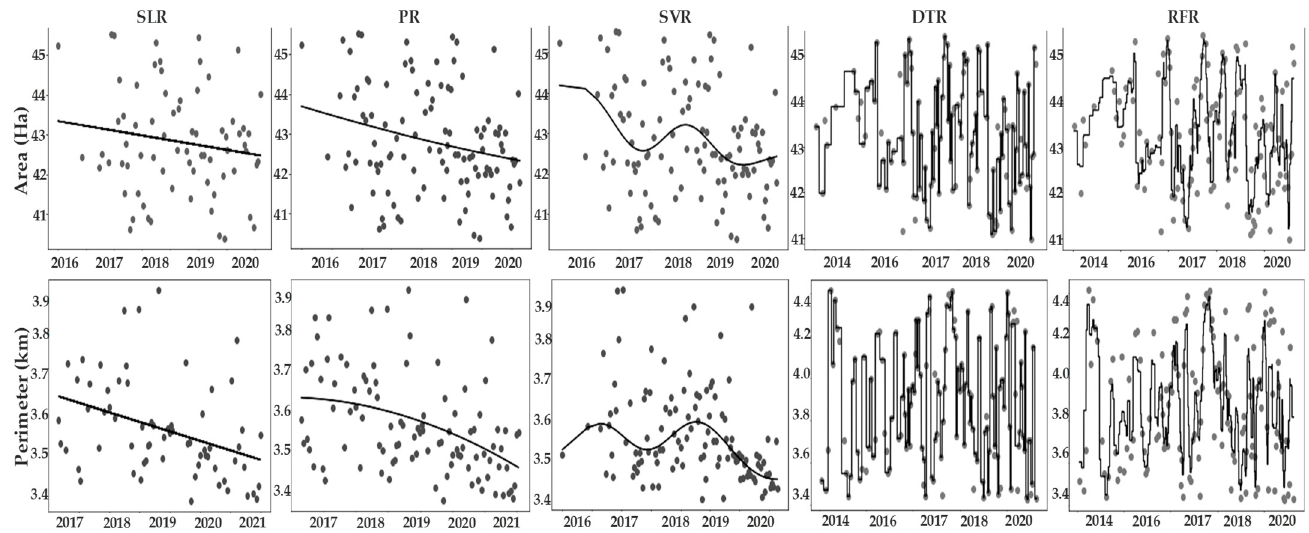
Figure 8. Regression models with greater R 2 for the area and perimeter data of Burlan Lake.